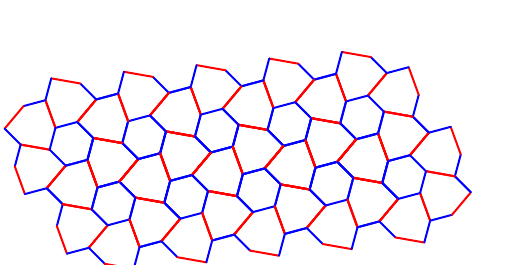
of having different angles.